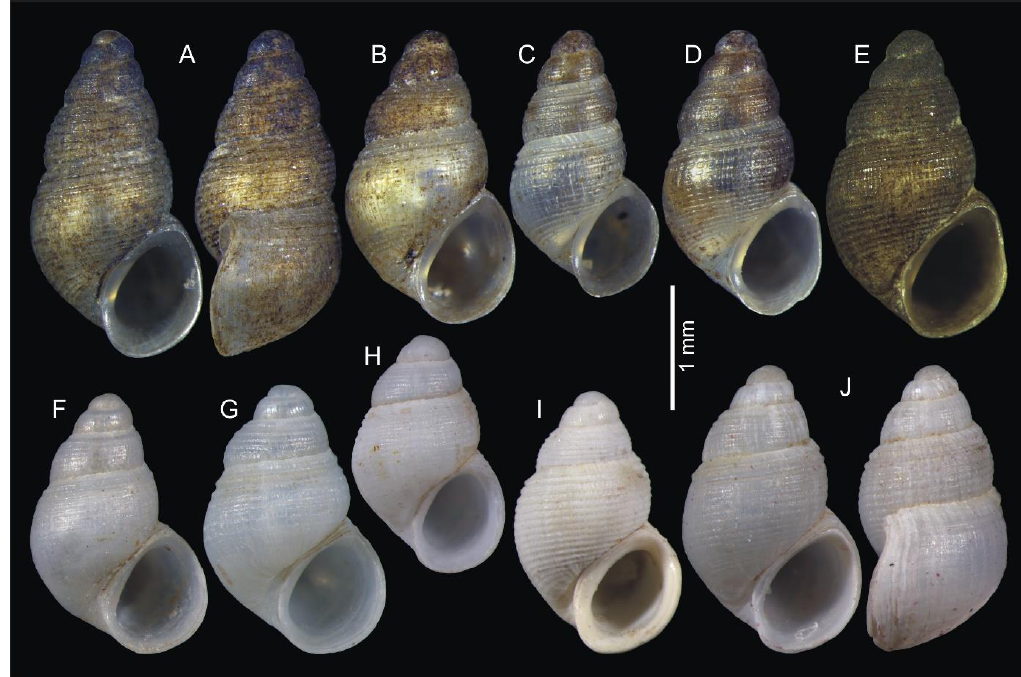
Figure 5. Shells of some other species of Clathrocaspia : ( A – E ) — shells of C . knipowitschii : ( A ) — speci-